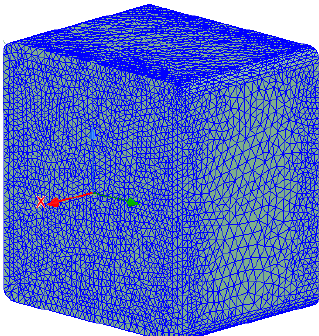
Figure 6. Convergence graph and iterated mesh elements.